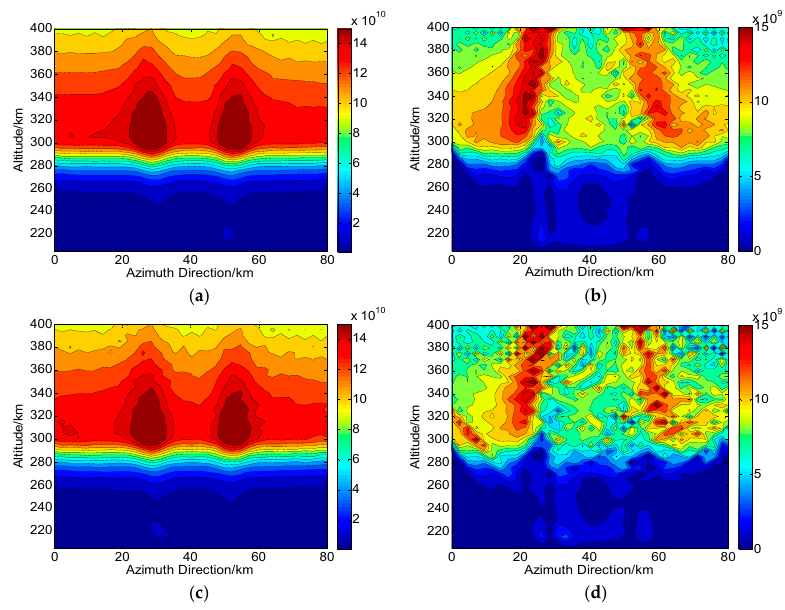
Figure 11. Two-dimensional CIT reconstructions under the condition of channel phase imbalance ( 20 ° ) in Changbai. ( a , c ) are the reconstructed results based on (20 ◦ ) in Changbai. ( a , c ) are the reconstructed results based on Ω F and Ω BB , respectively. ( b , d ) are the corresponding absolute deviations between the true and reconstructed results. The unit of the electron density is electrons · m − 3 .